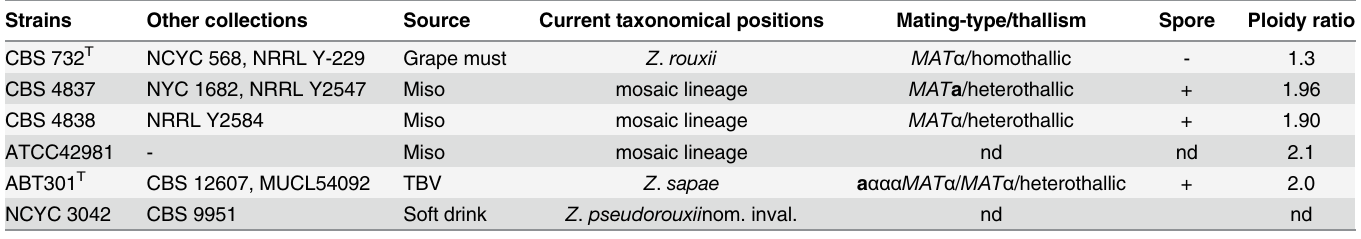
Table 1. Details of strains used in the present study. Ploidy data were obtained from Solieri et al. [23] [26], while the genotype of strain ABT301 T at the active MAT loci was obtained from Solieri et al. [32].